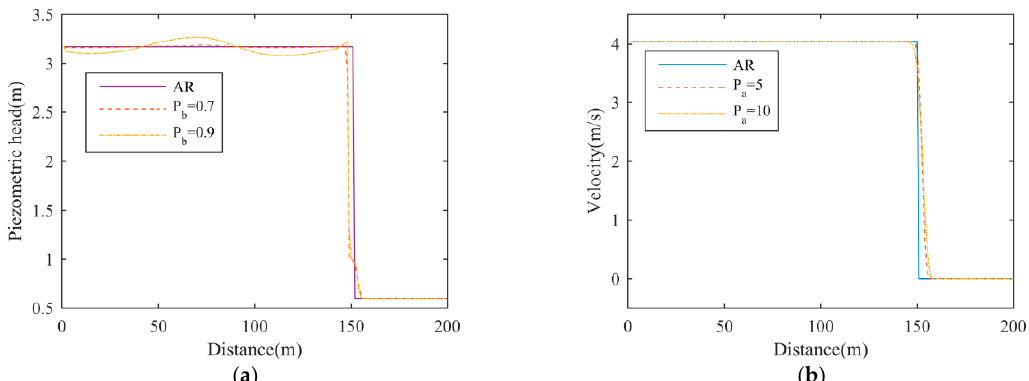
Figure 14. Comparison of the results simulated by P_HLL, with P a = 5 and P b = 0.7 or P b = 0.9, and the analytical result (AR): ( a ) piezometric head; ( b ) flow velocity.